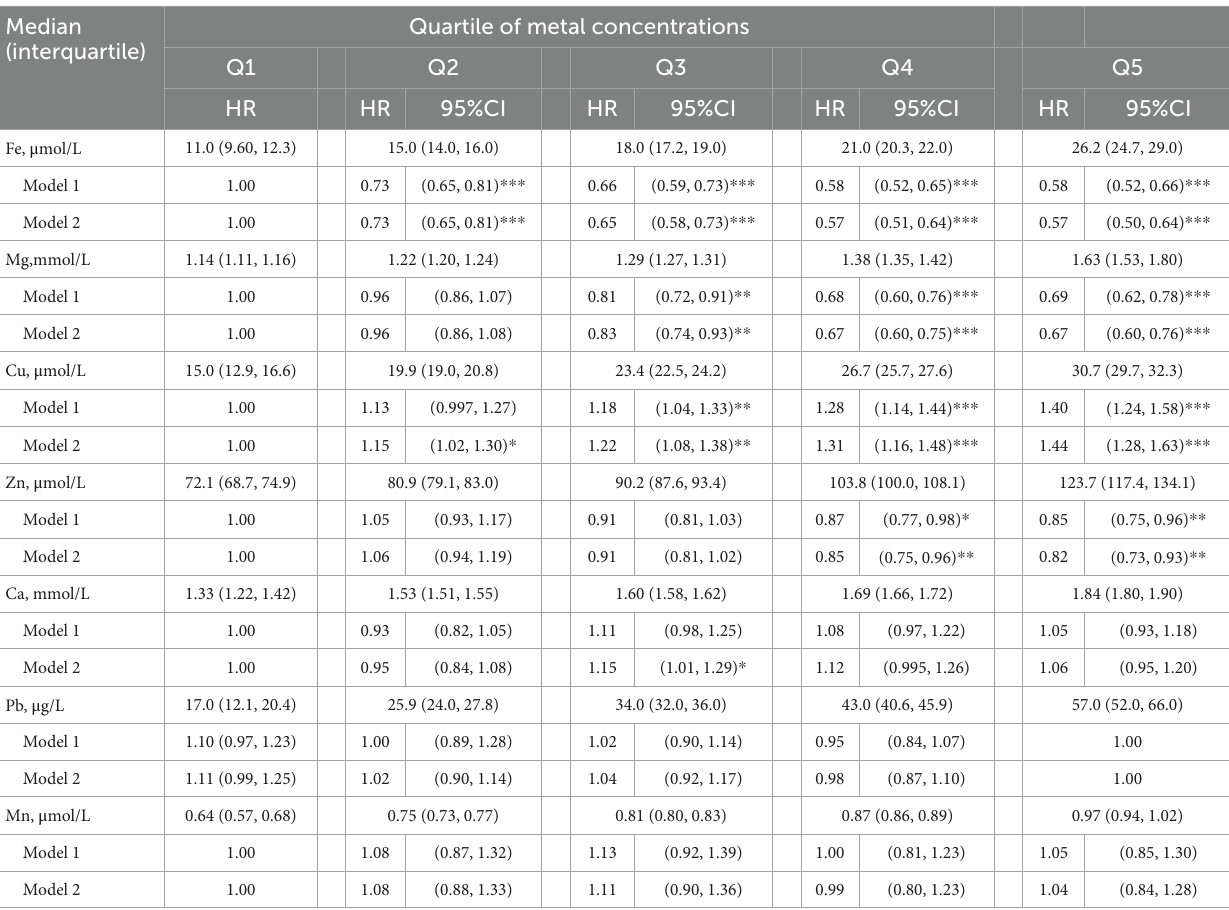
TABLE 3 Cox regression analyses of quartile of metal concentrations and postpartum anemia. Median (interquartile)